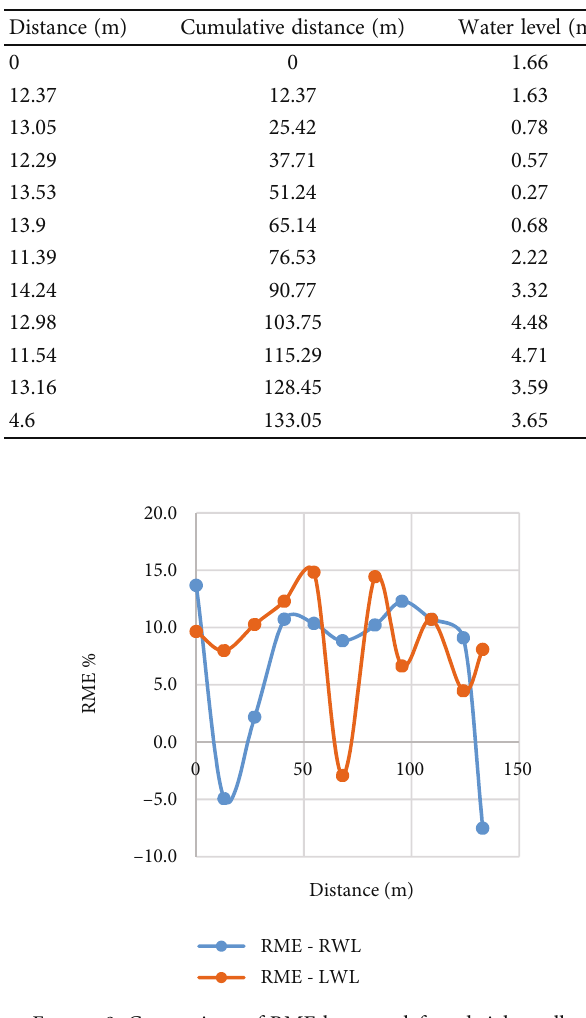
Figure 9: Comparison of RME between left and right walls.